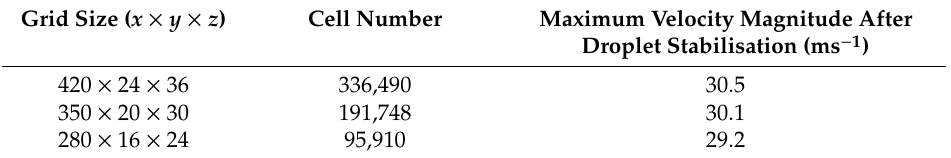
Table 3. Grid sensitivity test